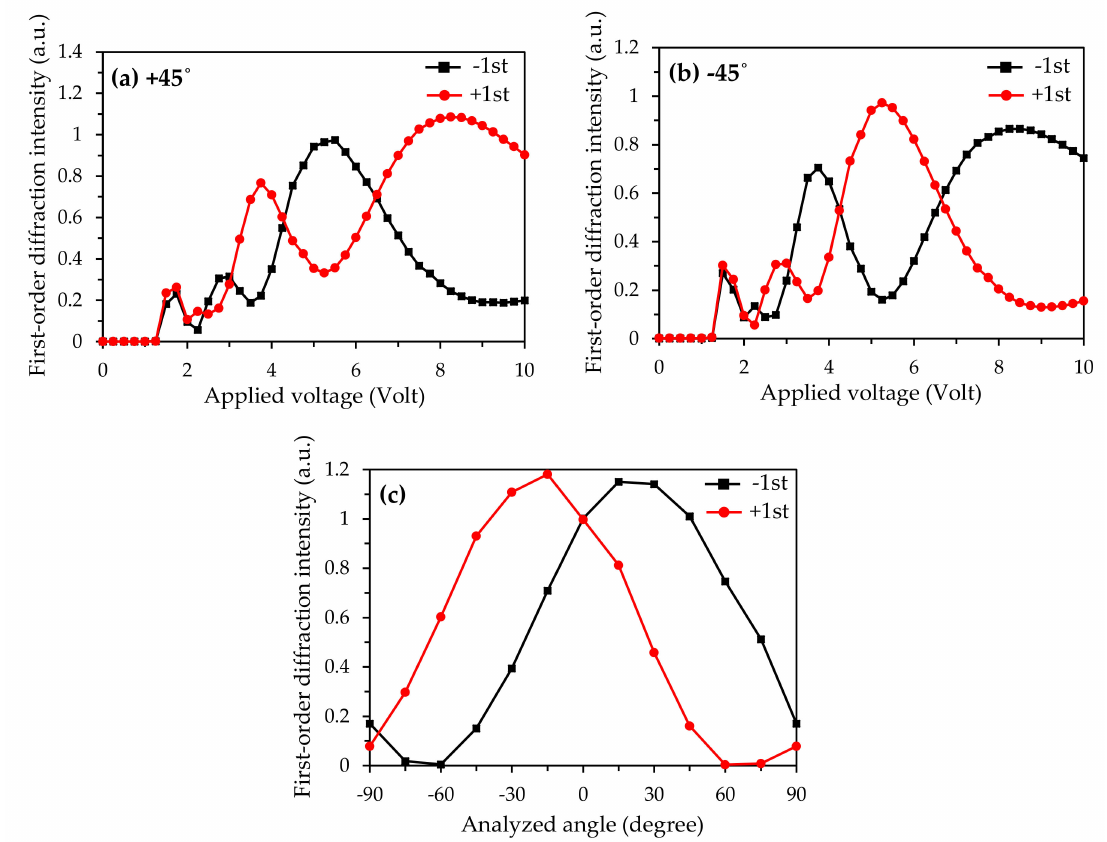
Figure 4. Variations of the applied voltage on the intensities of the ± 1st order di ff ractions when the analyzer is ( a ) 45 ◦ and ( b ) − 45 ◦ relative to the incident polarization. ( c ) Variations of the analyzed angle on the intensities of the ± 1st order di ff